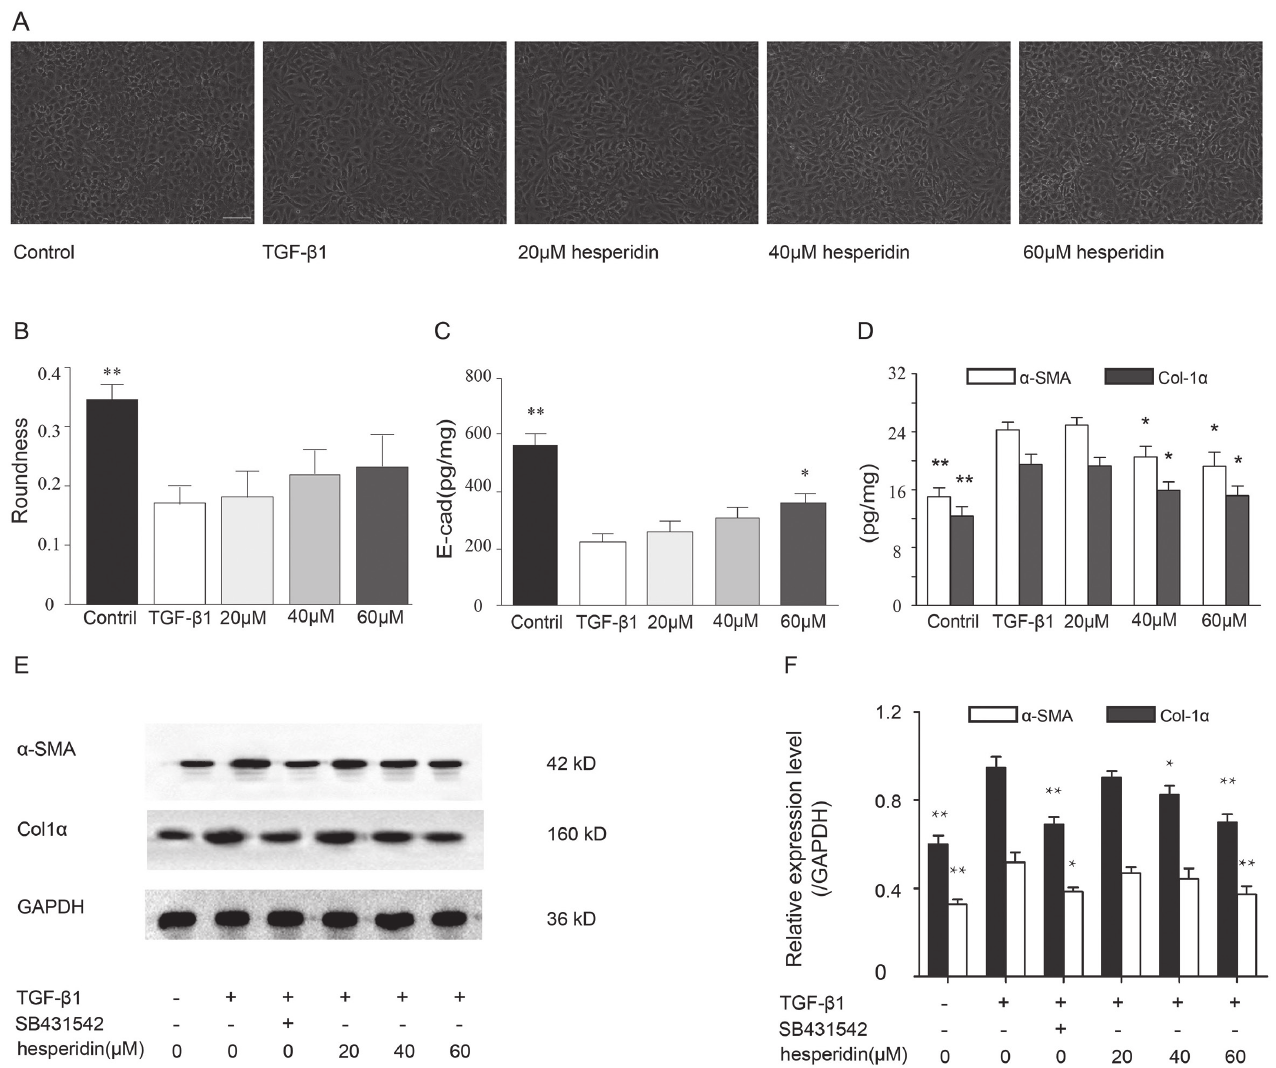
FIGURE 2 - Effect of hesperidin on the epithelial to mesenchymal transition. (A). The cells were treated with TGF-β1 (7.5 ng/mL) and various concentrations of hesperidin (0-60 μM) for 48 h. After TGF-β1 treatment, the cell morphology changed from a pebble- like shape to an elongated shape (magnification 100 ×). (B-D). Hesperidin did not significantly inhibit a decrease in the roundness value but significantly inhibited the downregulation of E-cad and the upregulation of α-SMA and Col-1α in a dose-dependent manner, as determined by ELISA assays. (E and F). The Western blotting assays evaluated the effect of hesperidin on Col-1ɑ and ɑ-SMA protein expression. Lanes 1, 2, 3, 4, 5 and 6 represent the normal control, TGF-β1 control, SB431542+TGF-β1, 20 μM heperidin+TGF-β1, 40 μM heperidin+TGF-β1 and 60 μM heperidin+TGF-β1 groups, respectively. The GADPH expression was the loading control. The quantitative data, expressing the corresponding proteins levels, were assessed using densitometry and are expressed in relative intensity arbitrary units in the panels. The bar represents the standard error of the mean (n = 5). *p < 0.05 and **p < 0.01 compared to the TGF-β1control